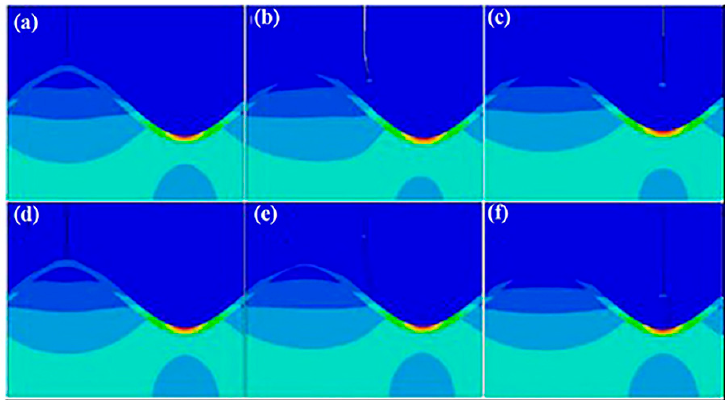
Figure 8. Crack propagation paths in the TBCs for different crack positions and TGO with different elastic modulus: ( a ) peak, E TGO = 400 GPa, ( b ) middle, E TGO = 400 GPa, ( c ) valley, E TGO = 400 GPa, ( d ) peak, E TGO = 40 GPa, ( e ) middle, E TGO = 40 GPa, and ( f ) valley, E TGO = 40 GPa. Reprinted with permission from [59]; Copyright 2012 Elsevier.